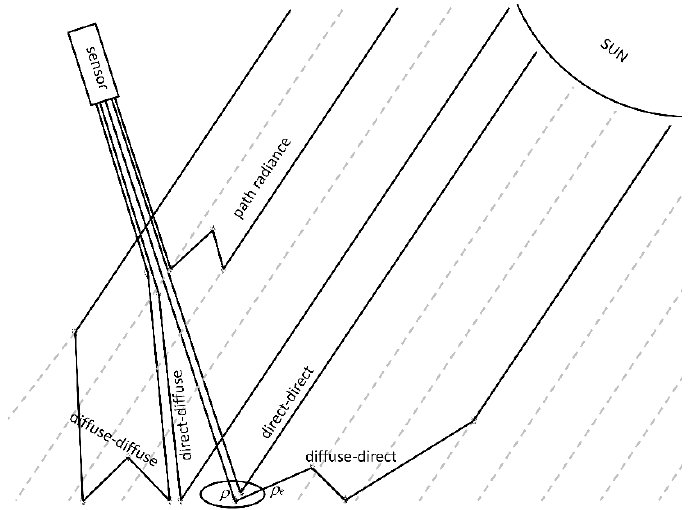
Figure 1. Radiative transfer in the atmosphere/soil system.